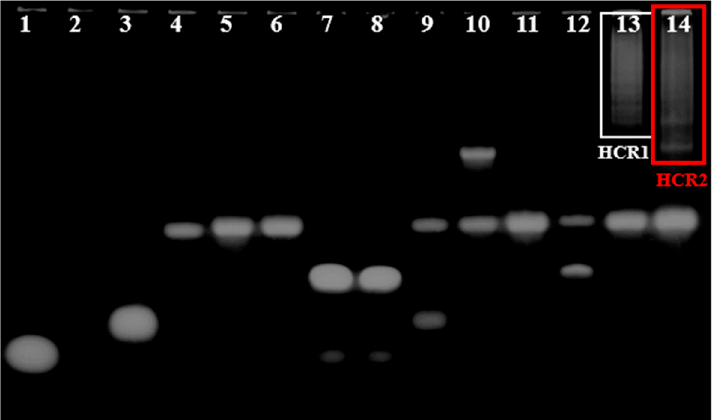
Figure 1. Polyacrylamide gel electrophoresis (PAGE) confirms the feasibility of the Exo Ι cleavage function and the HCR reaction. (lane 1: capture probe; lane 2: capture probe and Exo Ι ; lane 3: target; lane 4: initiator; lane 5: hairpin H1; lane 6: hairpin H2; lane 7: capture probe and target; lane 8: capture probe, target, and Exo Ι ; lane 9: target and initiator; lane 10: initiator and hairpin H1; lane 11: hairpin H1 and hairpin H2; lane 12: capture probe, target, and initiator; lane 13: initiator, hairpin H1, and hairpin H2; lane 14: capture probe, target, initiator, hairpin H1, and hairpin H2.)